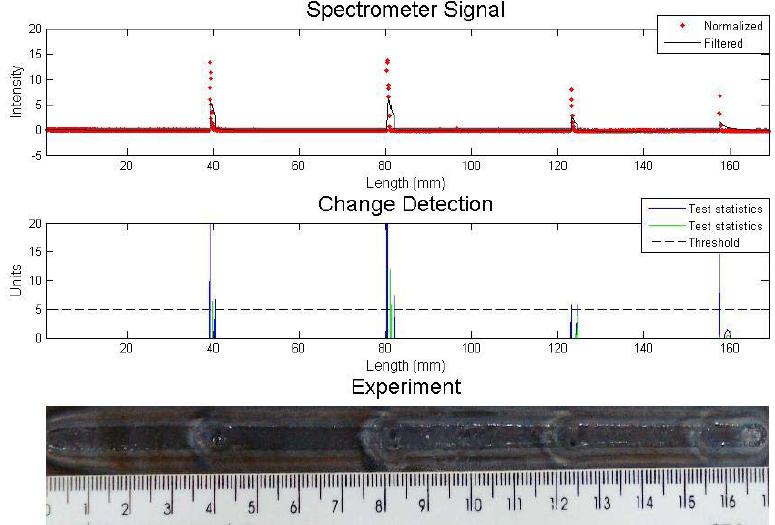
Figure 9. Experiment with sprayed water – analysis with proposed algorithm.